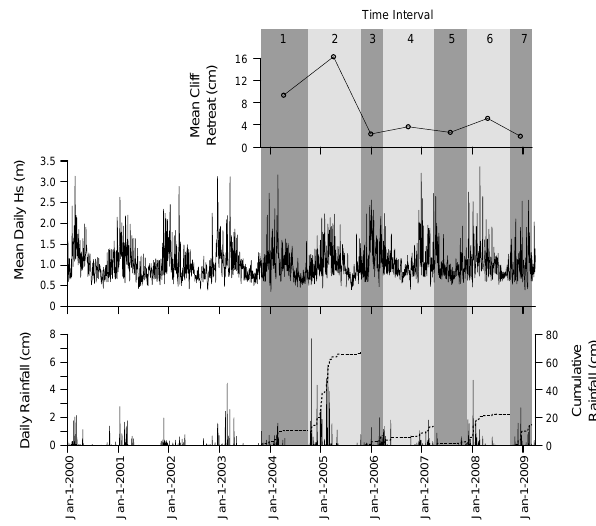
Fig. 4. Top: mean section cliff retreat occurring during each time interval. Center: mean daily significant wave height ( H s ) at a virtual buoy located seaward of the cliff section in 10m water depth (monitoring and prediction point location (MOP), Fig. 1). Bottom: daily rainfall totals and cumulative daily rainfall during each interval (dotted line) at Cabrillo National Monument (http://www.wrh.noaa.gov/sgx/obs/rtp/cabrillo.html) located at the southern end of the study area. Gray bars indicate time periods between lidar surveys used in this